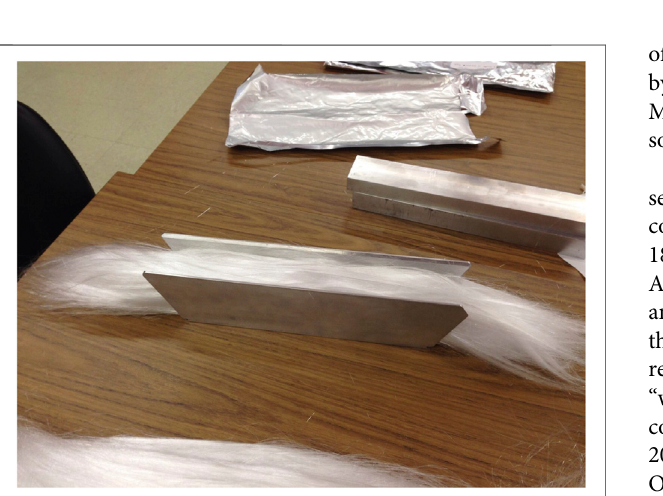
Frontiers in Physics |